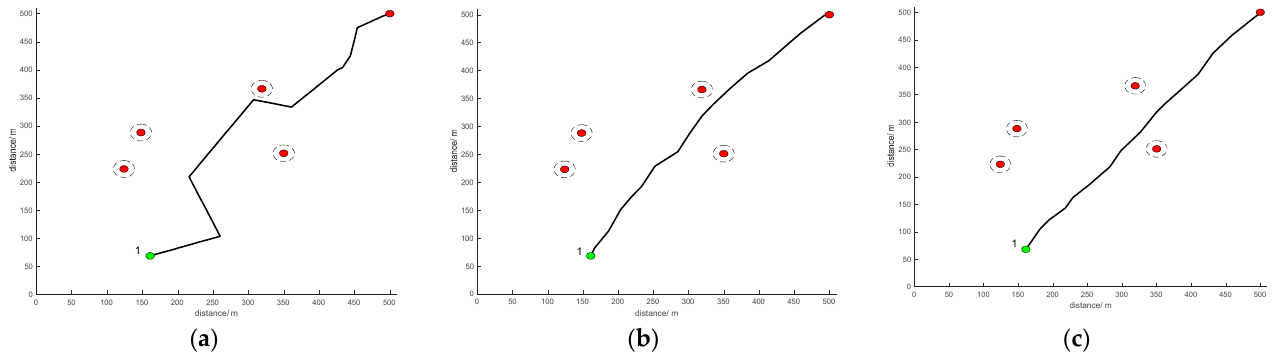
dashed dots indicate the vehicle that has completed path regularization.